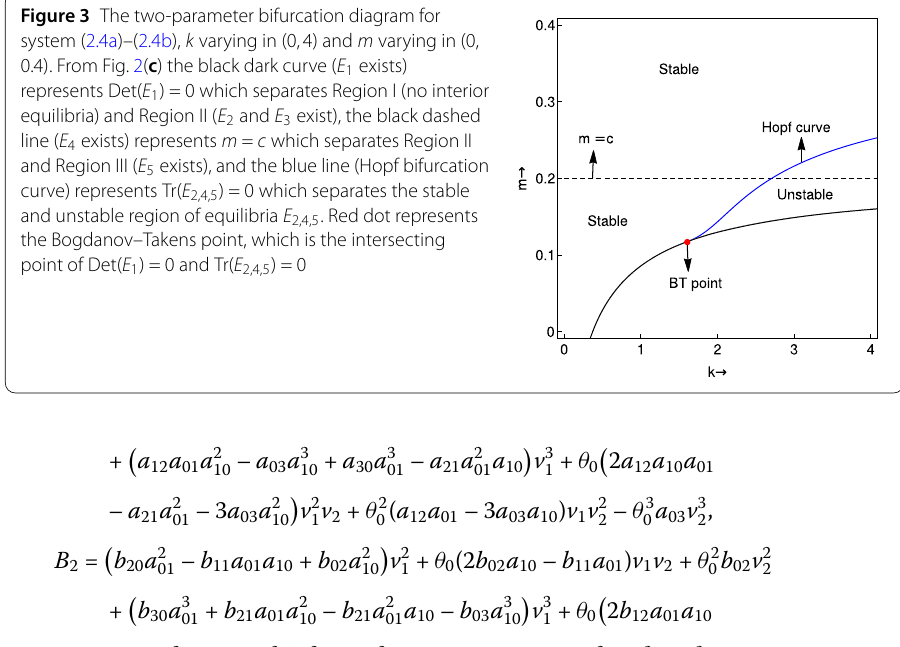
Figure 3 The two-parameter bifurcation diagram for system (2.4a)–(2.4b), k varying in (0,4) and m varying in (0, 0.4). From Fig. 2( c ) the black dark curve ( E 1 exists) represents Det( E 1 ) = 0 which separates Region I (no interior equilibria) and Region II ( E 2 and E 3 exist), the black dashed line ( E 4 exists) represents m = c which separates Region II and Region III ( E 5 exists), and the blue line (Hopf bifurcation curve) represents Tr( E 2,4,5 ) = 0 which separates the stable and unstable region of equilibria E 2,4,5 . Red dot represents the Bogdanov–Takens point, which is the intersecting point of Det( E 1 ) = 0 and Tr( E 2,4,5 ) =